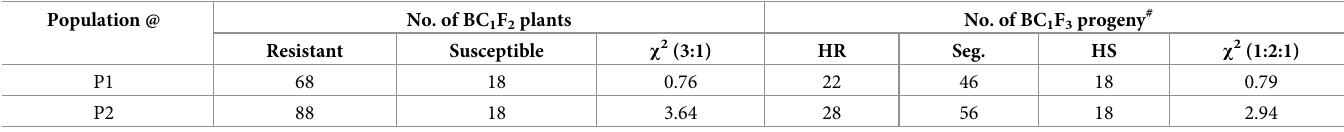
Table 1. Segregation and chi-square analysis of resistance in BC 1 F 2 plants and BC 1 F 3 progeny indicates segregation of single dominant locus. Population @ No. of BC 1 F 2 plants No. of BC 1 F 3 progeny